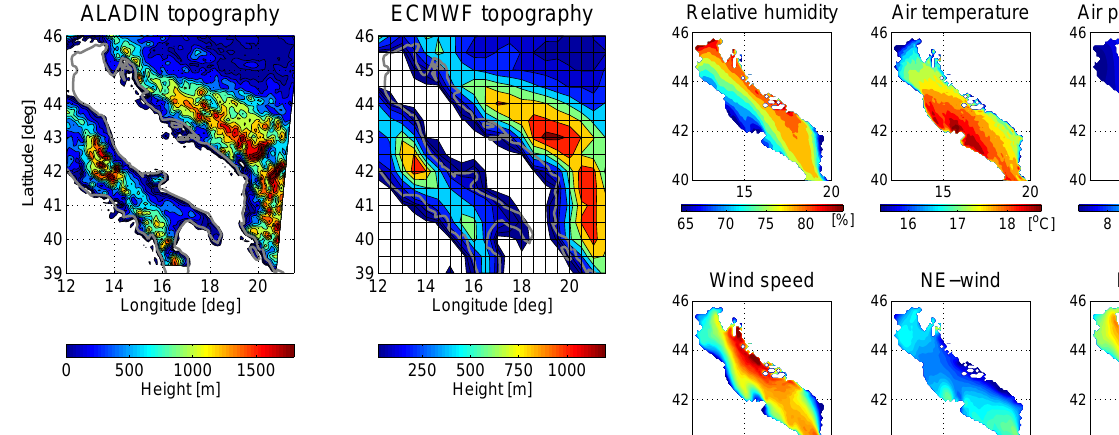
Fig. 1. ALADIN and ECMWF orography. The actual coastline is shown in grey. The 0.5 degrees ECMWF grid is shown on the right panel. The height levels shown are 20, 50, 100, 200, 400, 600,... m.